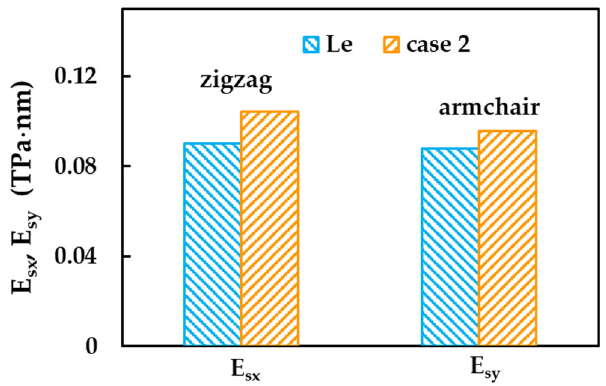
Figure 8. Comparison of the current surface Young’s moduli, E sx (zigzag direction) and E sy (armchair direction), for the InNNSs of Case 2, size 3, with those of Le [9]. The results obtained for NSs of similar size were chosen for comparison purposes.